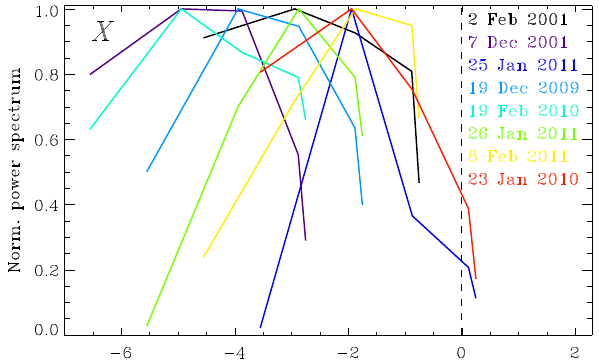
Figure 10. The statistical distribution of IPCL spectral power ( X component) for 8 events along the NAL–LYR–HOR–HOP– BJN–SOR profile with respect to the distance from the equatorward cusp boundary. All the spectra have been normalized by their max- imal